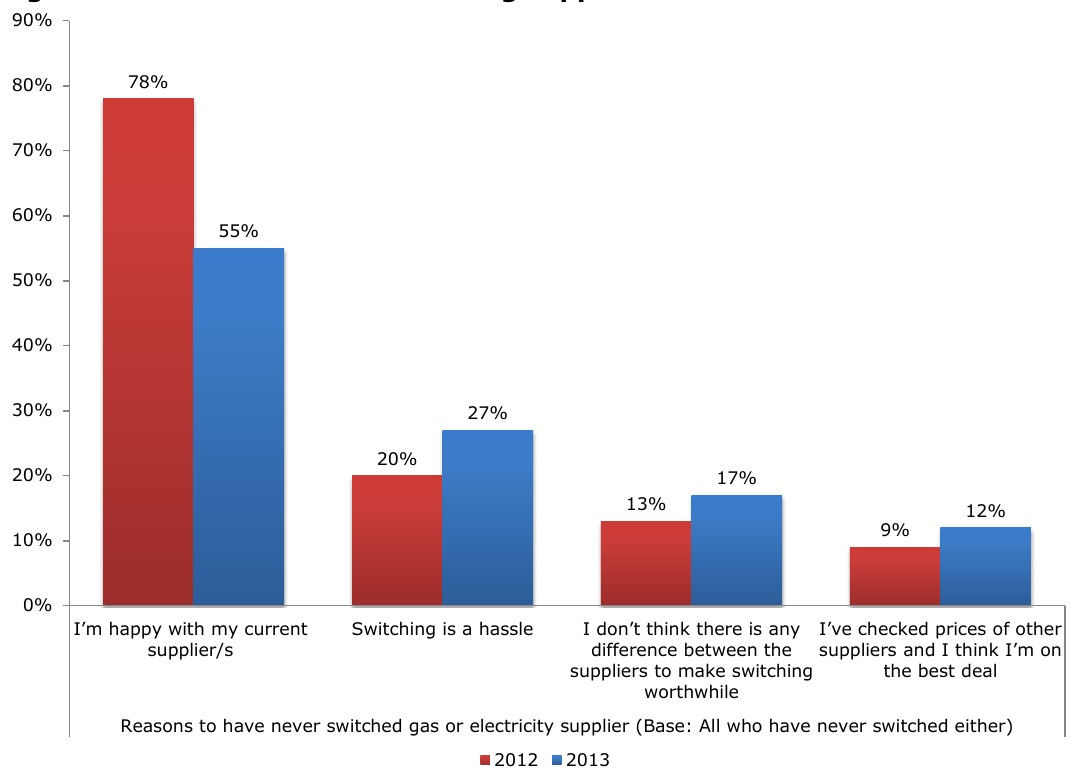
Figure 14: Reasons for not switching